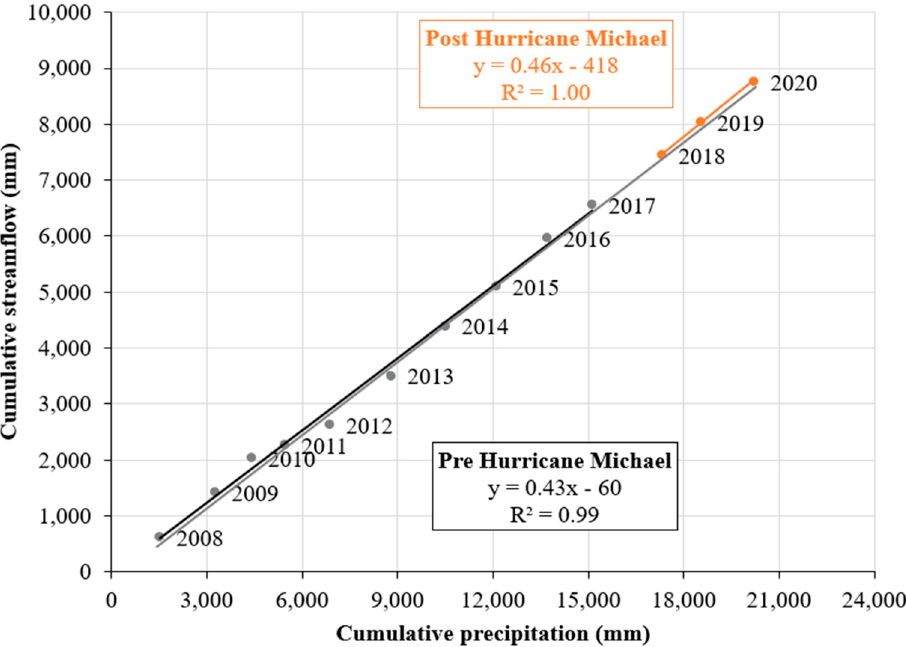
Figure 9. Double Mass Curve (Accumulative annual precipitation vs. streamflow for the period from 2007 to 2020) for Chipola River Watershed for detecting streamflow change during 2018–2020 due to Hurricane Michael in October 2018.